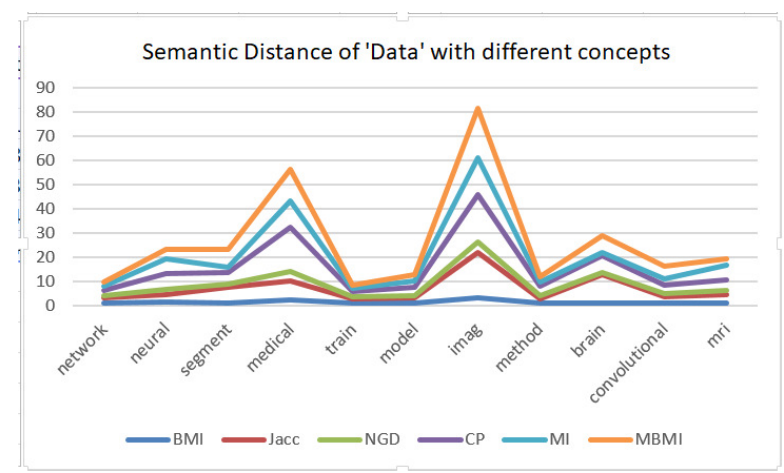
Figure 12. Semantic Distance of term “Data” with cross domain terms using different